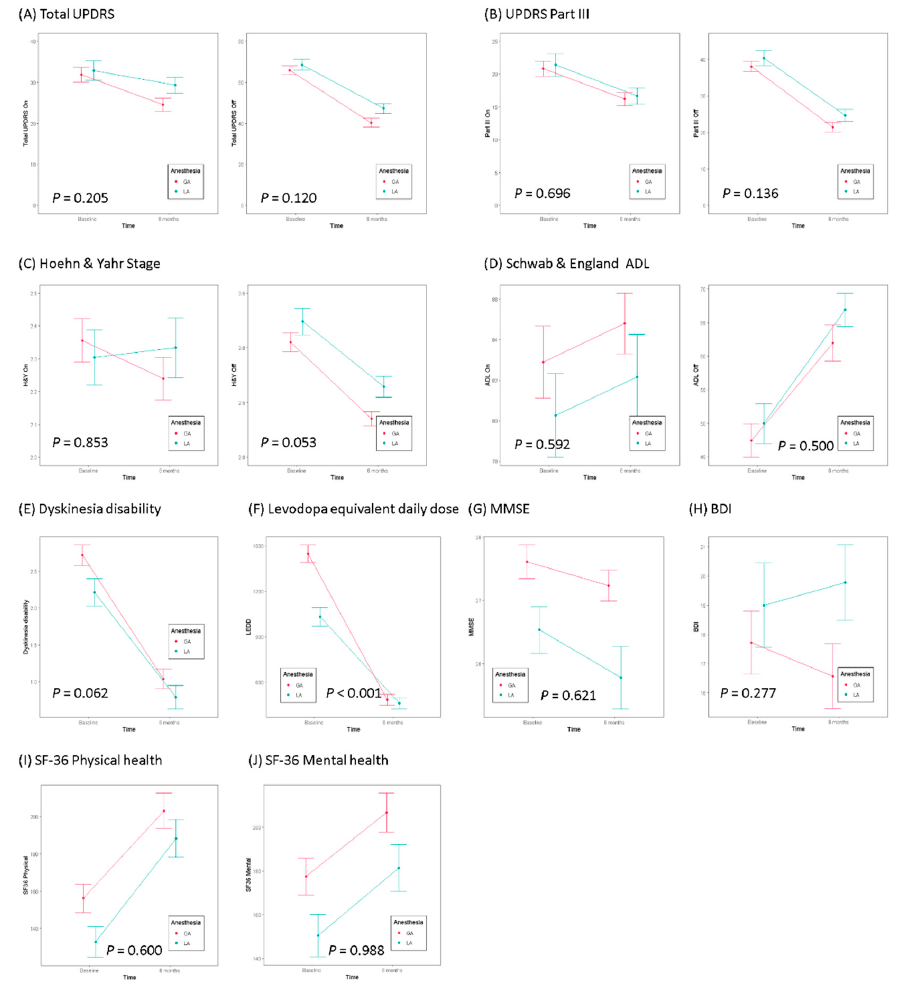
Figure 1. Comparison of clinical outcomes between baseline and 6 months after STN Deep brain stimulation (DBS) under local anesthesia (LA) and general anesthesia (GA) each cohort. ( A ) Total